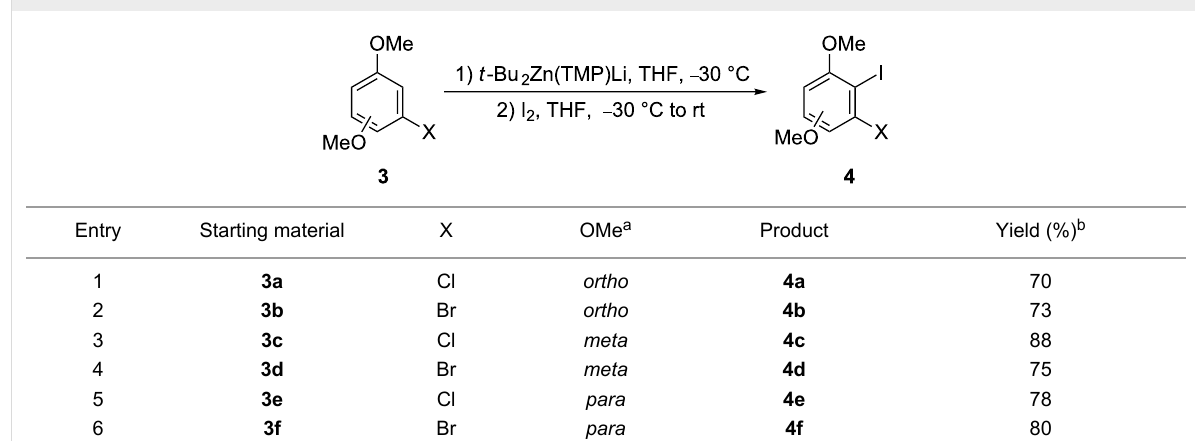
Table 1: Synthesis of methoxy-substituted 3-halo-2-iodoanisoles 4 .